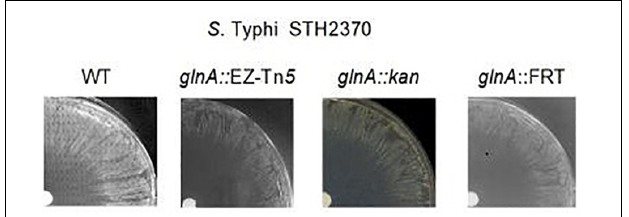
FIGURE 1 | Salmonella Typhi mutants in glnA gene show susceptibility to ciprofloxacin. A disk diffusion assay was performed to measure inhibition zones of S. Typhi STH2370 (WT), S. Typhi STH2370 glnA ::EZ-Tn 5 , S. Typhi STH2370 glnA :: kan and S. Typhi STH2370 glnA ::FRT. The strains were seeded onto MH agar plates pH 7.3. Followed, 5 µ L of ciprofloxacin 2 mg/mL were spotted onto a filter paper disk and placed on the plates and incubated at 37 ◦ C for 16–18 h.